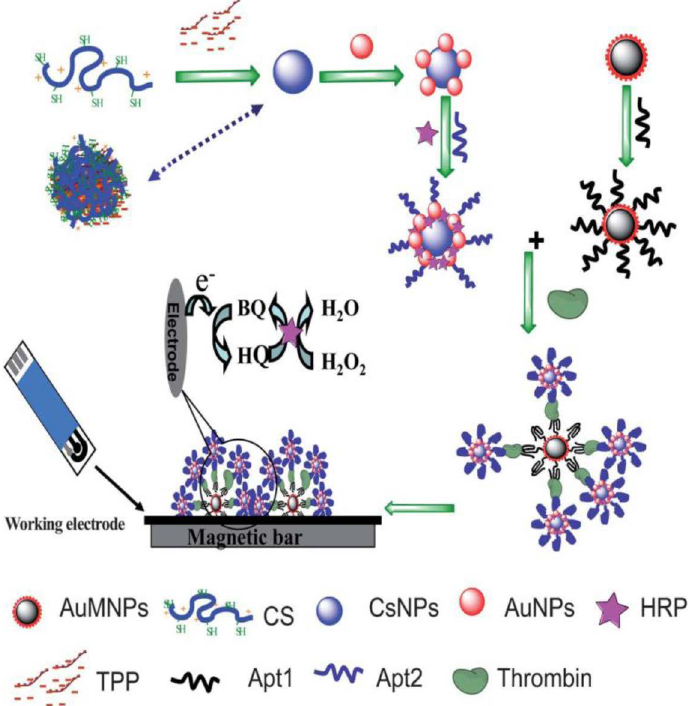
Figure 10. Scheme of the preparation of aptasensor for thrombin detection. Reprinted from Ref. [92] with